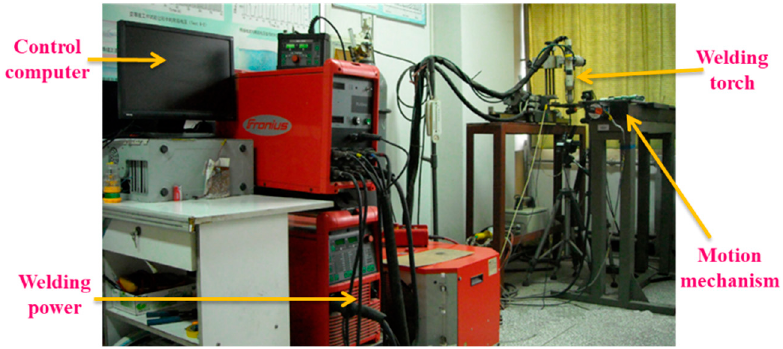
Figure 10. Plasma arc welding system.